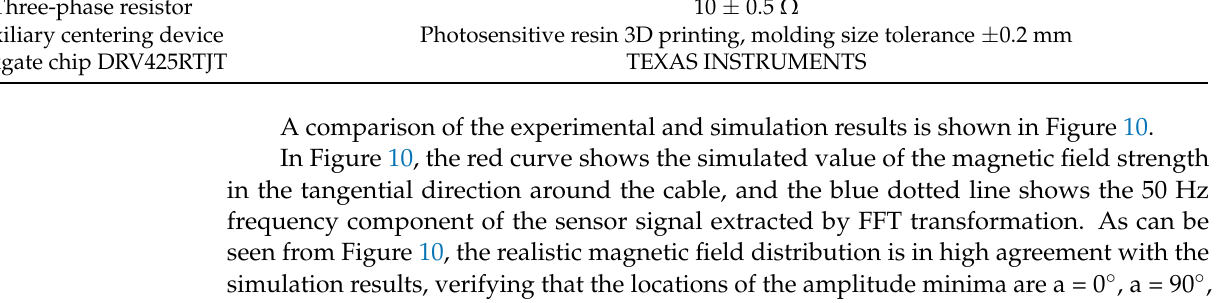
Table 4. Experimental instruments and performance parameters.